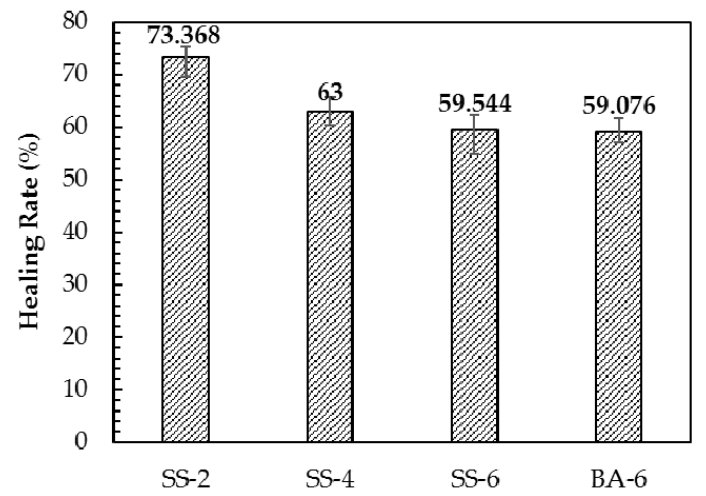
ff erent asphalt